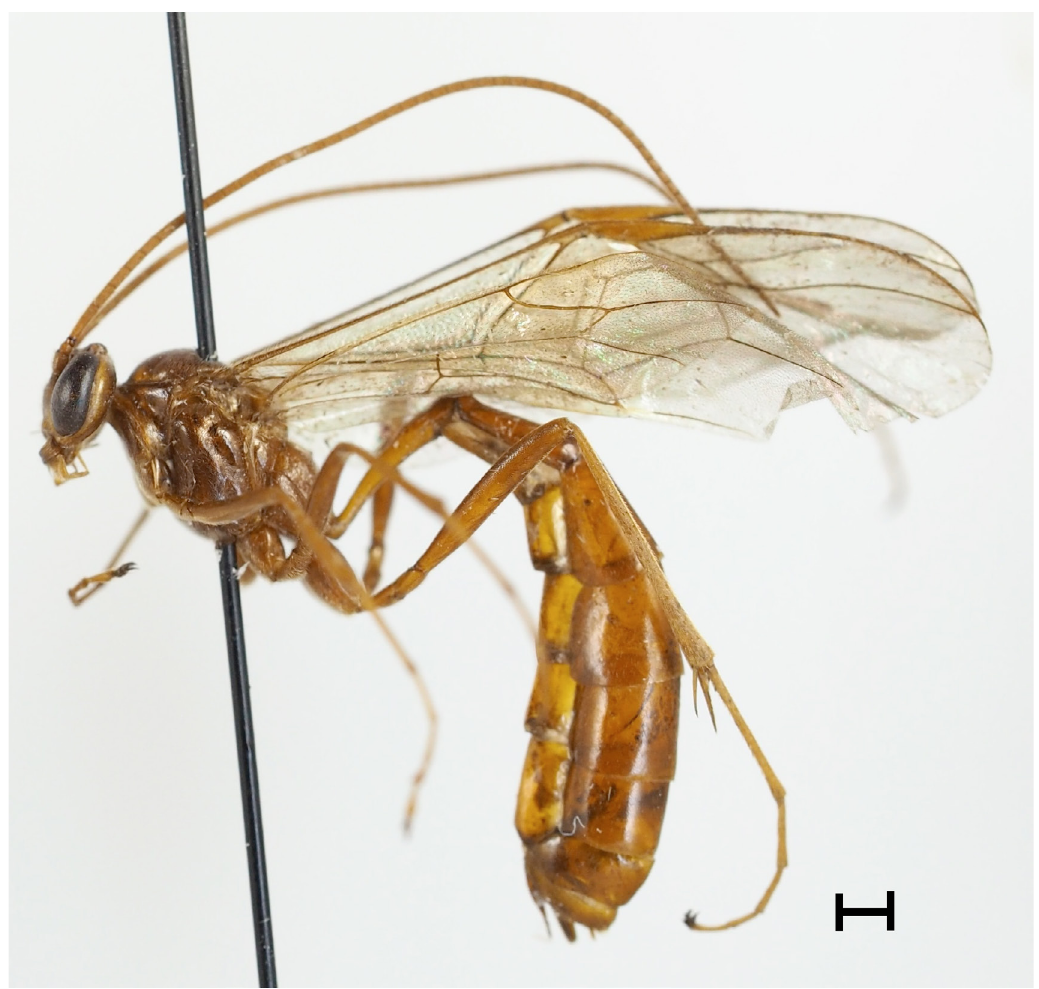
Fig. 23. Ophion arenarius Johansson sp. nov., paratype, ♀ (NHRS-HEVA000008606). Scale bar = 1